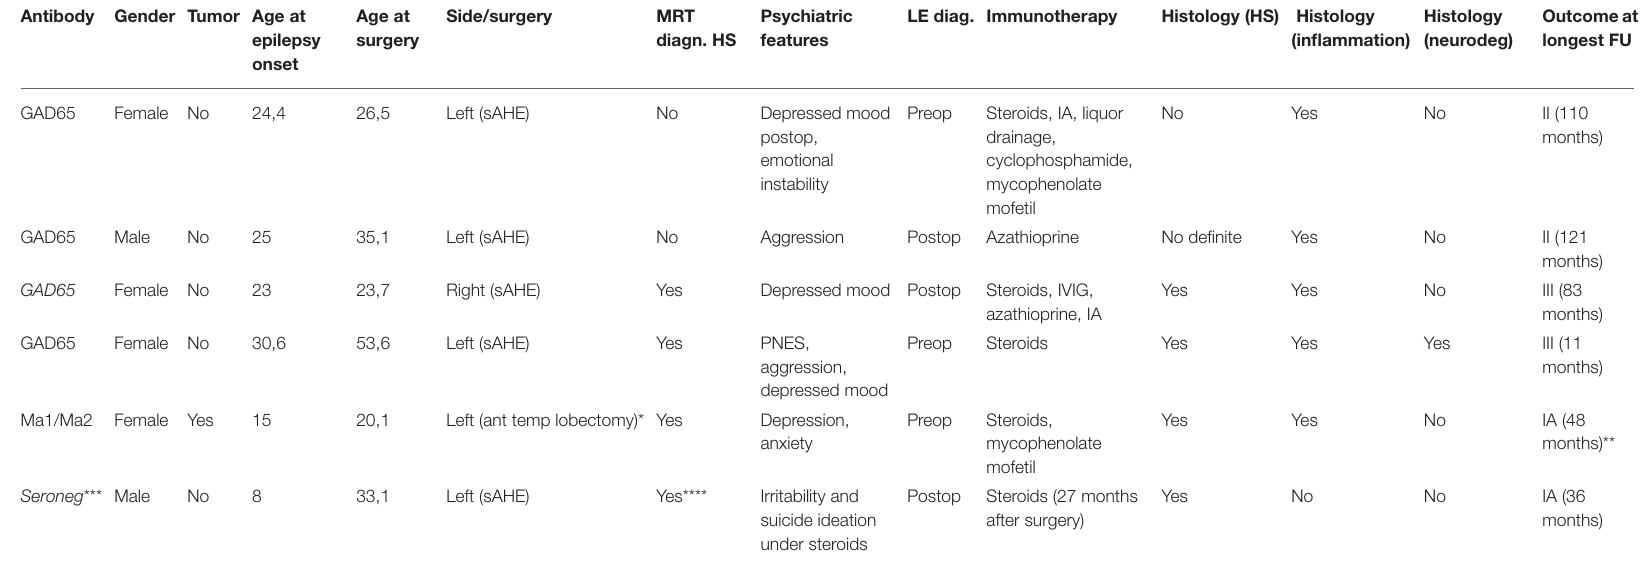
* Two surgeries. ** Outcome after the second surgery (roughly 7 months after first surgery). *** VGKC (no LGI1, no CASPR2) and low titer NMDAR IgM antibodies (unspecific finding). **** On both sides. FU, follow-up; IA, immunadsorption; IVIG, intravenous immunglobuline; LE, limbic encephalitis; HS, hippocampal sclerosis; PNES, psychogenic, non-epileptic seizures; sAHE, selective amygdalohippocampectomy. Patients with antibodies in italic script presented a contralateral inflammation more than 1 year after